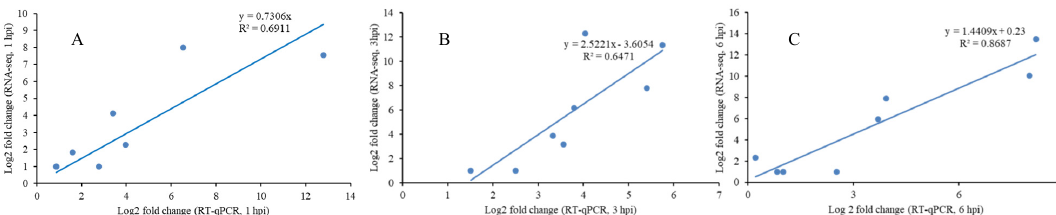
Figure 3. The comparison of gene expression values obtained by RNA-seq and RT-qPCR at 1 hpi, 3 hpi and 6 hpi. ( A ) 1 hpi; ( B ) 3 hpi; ( C ) 6 hpi. The RNA-seq log2 values of the expression ratio (infected versus uninfected) ( x -axis) was compared to the same values from the RT-qPCR ( y -axis). The R2 values show the correlation ratio between RNA-seq and RT-qPCR in each time point. p -value ≤ 0.05.